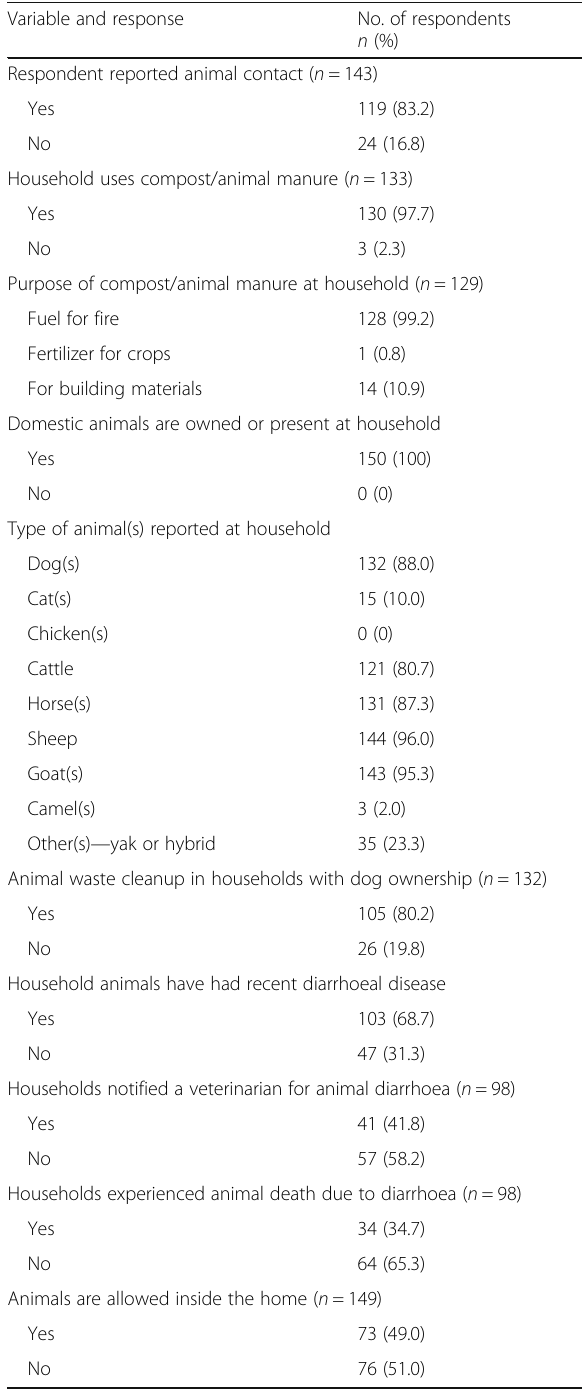
Table 3 Animal contact and zoonotic risk factors reported in Mongolian herding households ( n = 150) Variable and